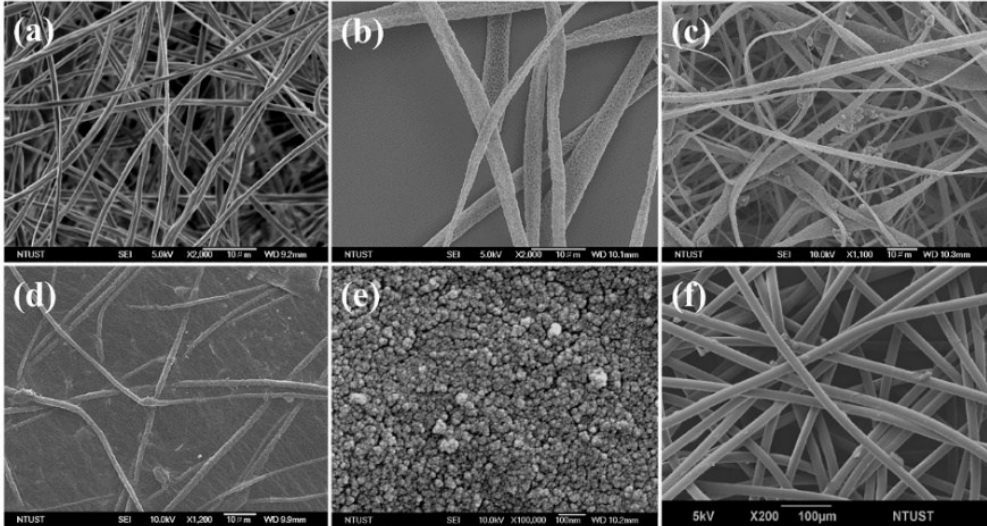
Figure 2. Field emission scanning electron microscopy images showing the morphology of ( a ) rTAC-nonporous fiber; ( b ) rTAC-porous fiber; ( c ) TiO 2 / rTAC-porous; ( d ) GO/rTAC-porous; ( e ) TiO 2 /GO/rTAC-porous; and ( f ) PP nonwoven fiber.